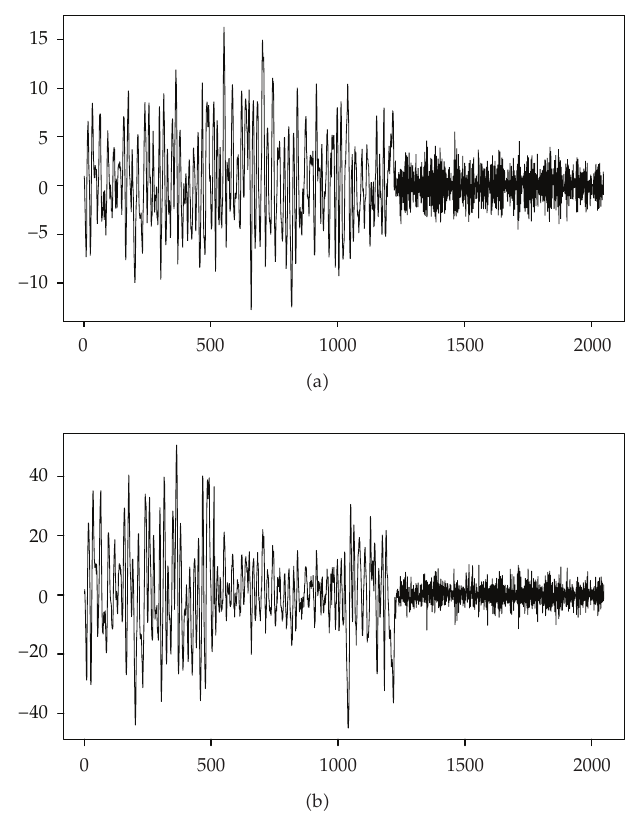
Figure 9: Example 5.3: (cid:5) a (cid:6) input series and (cid:5) b (cid:6) output